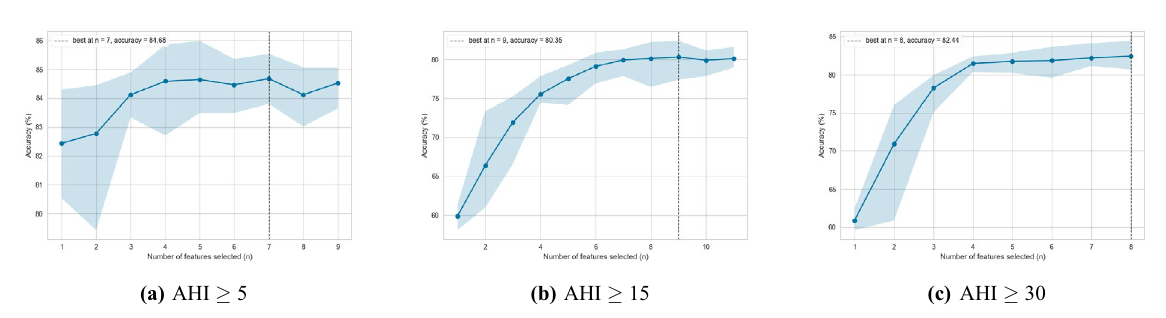
Figure 3. Visualised 5-fold cross-validation results of recursive feature elimination (RFE).